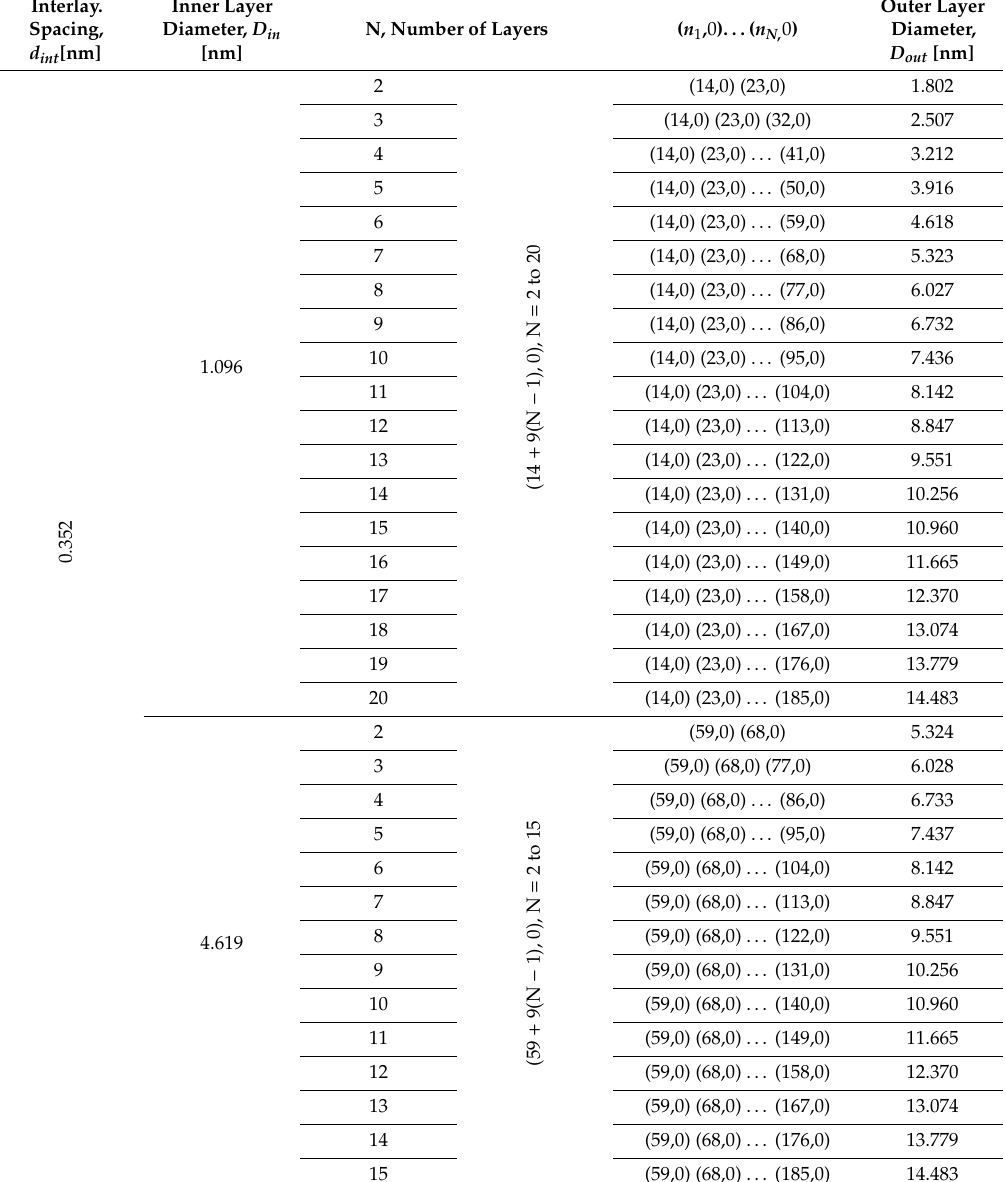
Table 3. Geometrical characteristics of zigzag MWCNTs, under study. Interlay.